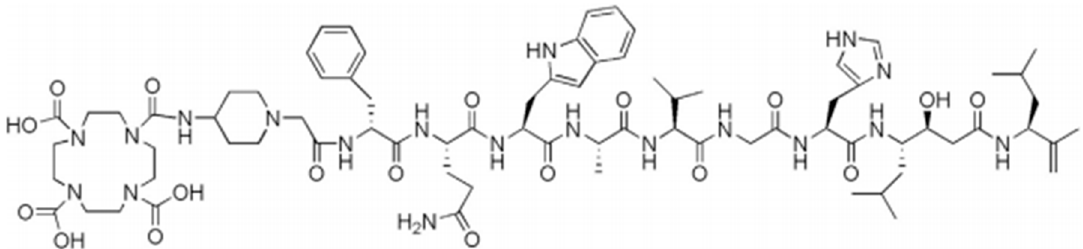
Figure 1. Structure of the RM2 peptide.